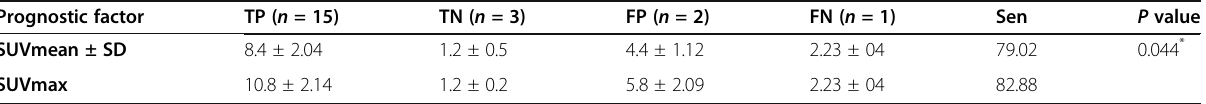
Table 3 The diagnostic value of SUVmean and SUVmax for initial staging in G1, n = 21 malignant melanoma cases